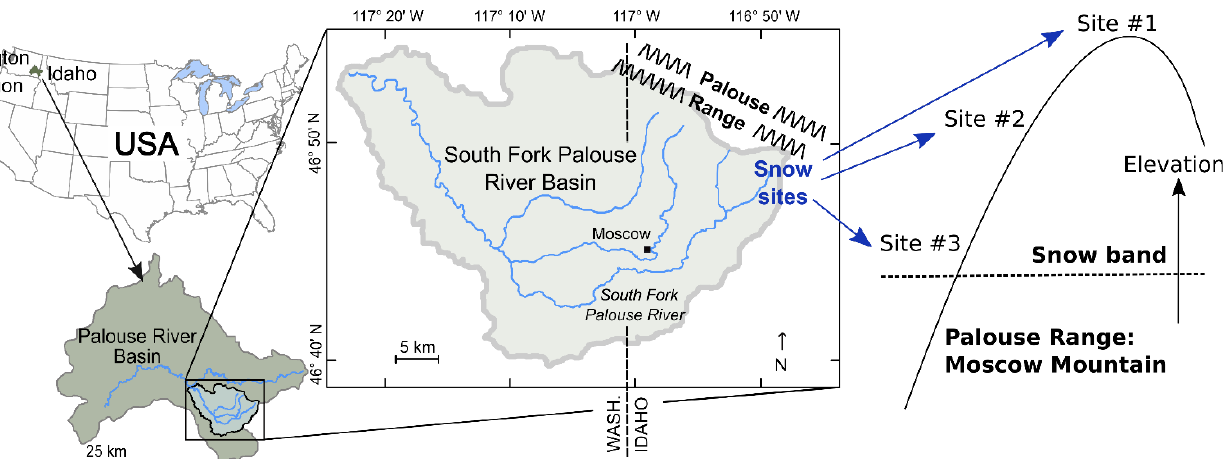
Figure 1. Study area location in the Palouse Range of the South Fork Palouse River Basin, northern Idaho, USA. Snow sampling network consisted of three sample locations within the primary snow band of Moscow Mountain.